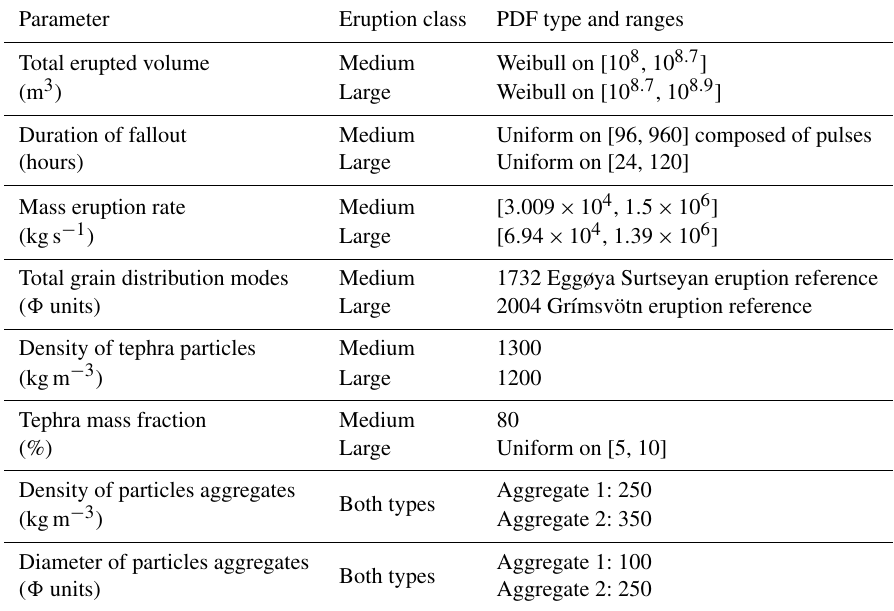
Table B1. PDFs and values ranges of the main eruptive parameters for JM. Bounds on mass eruption rate values are a consequence of the sampling procedure for total erupted volume (Fig. 3) and duration of the fallout phase described in the text. For the total grain size distribution, references were chosen from the 1732 Eggøya and 2004 Grímsvötn eruptions for medium and large classes respectively. Erupted volumes are between 0.1–0.5 and > 0 . 5km 3 for medium and large class ranges.